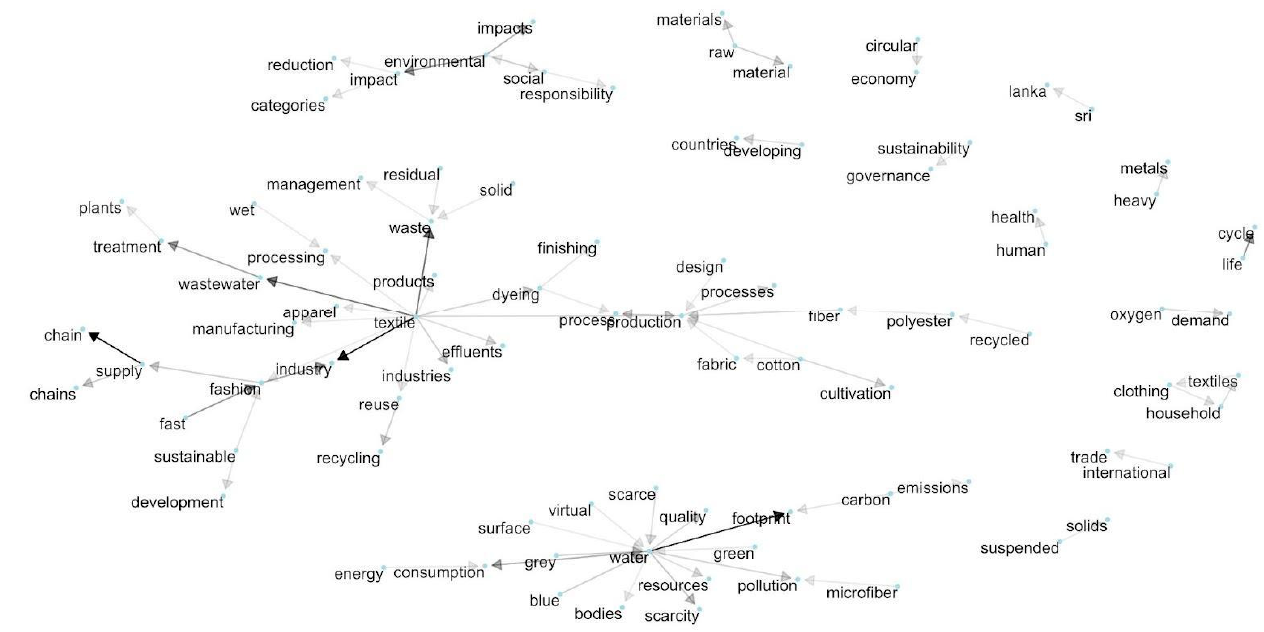
Figure 4. A bigram network plot of words that co-occur in the literature surrounding fast fashion and water quality based on full text analysis. “Textile” and “water” form the biggest nodes and branch out to other topics that are found throughout the literature. The most prevalent topics are indicated by dark arrows.